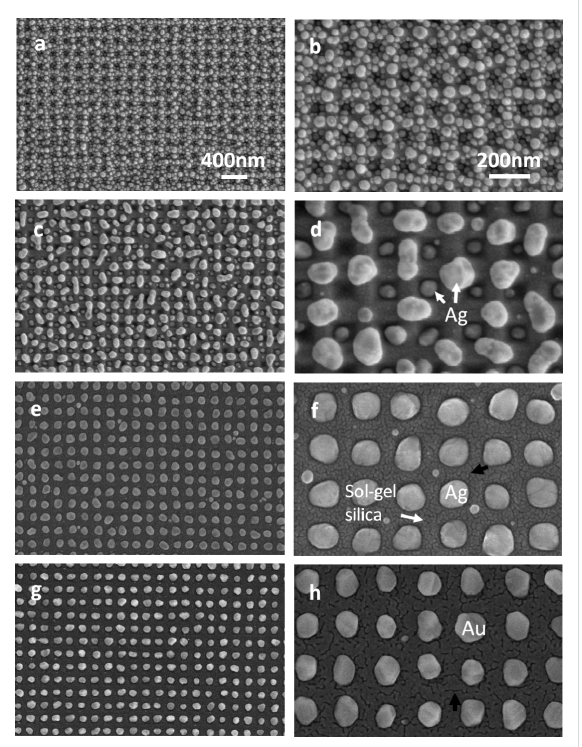
Figure 6: Metal nanoparticles formed on imprinted sol–gel silica: (a,b) 8 nm thick and (c,d) 10 nm thick Ag films dewetted at 300 °C, (e,f) 14 nm thick Ag and (g,h) Au films dewetted at 500 °C. Black arrows in images f and h indicate surface cracks formed in imprinted sol–gel